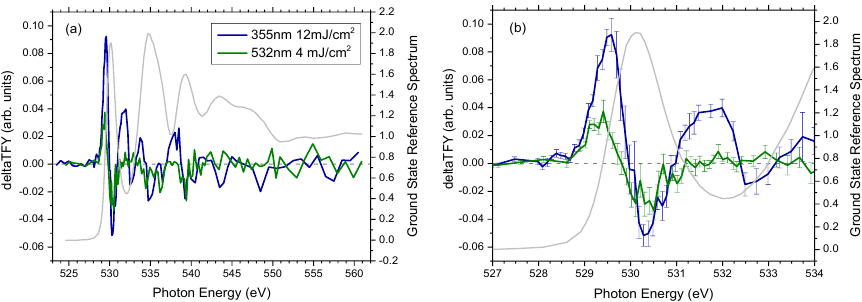
Fig. 1. a) Laser-induced changes in the oxygen K-edge absorption spectrum of CuO at laser wavelengths of 532 nm (green) and 355 nm (blue) compared to the static near-edge absorption spectrum (gray). b) Magnified view of the first resonance at 530.1 eV. The right and left axes correspond to the ground state spectra and transient differences, respectively. Error bars indicate standard errors of 10 individual